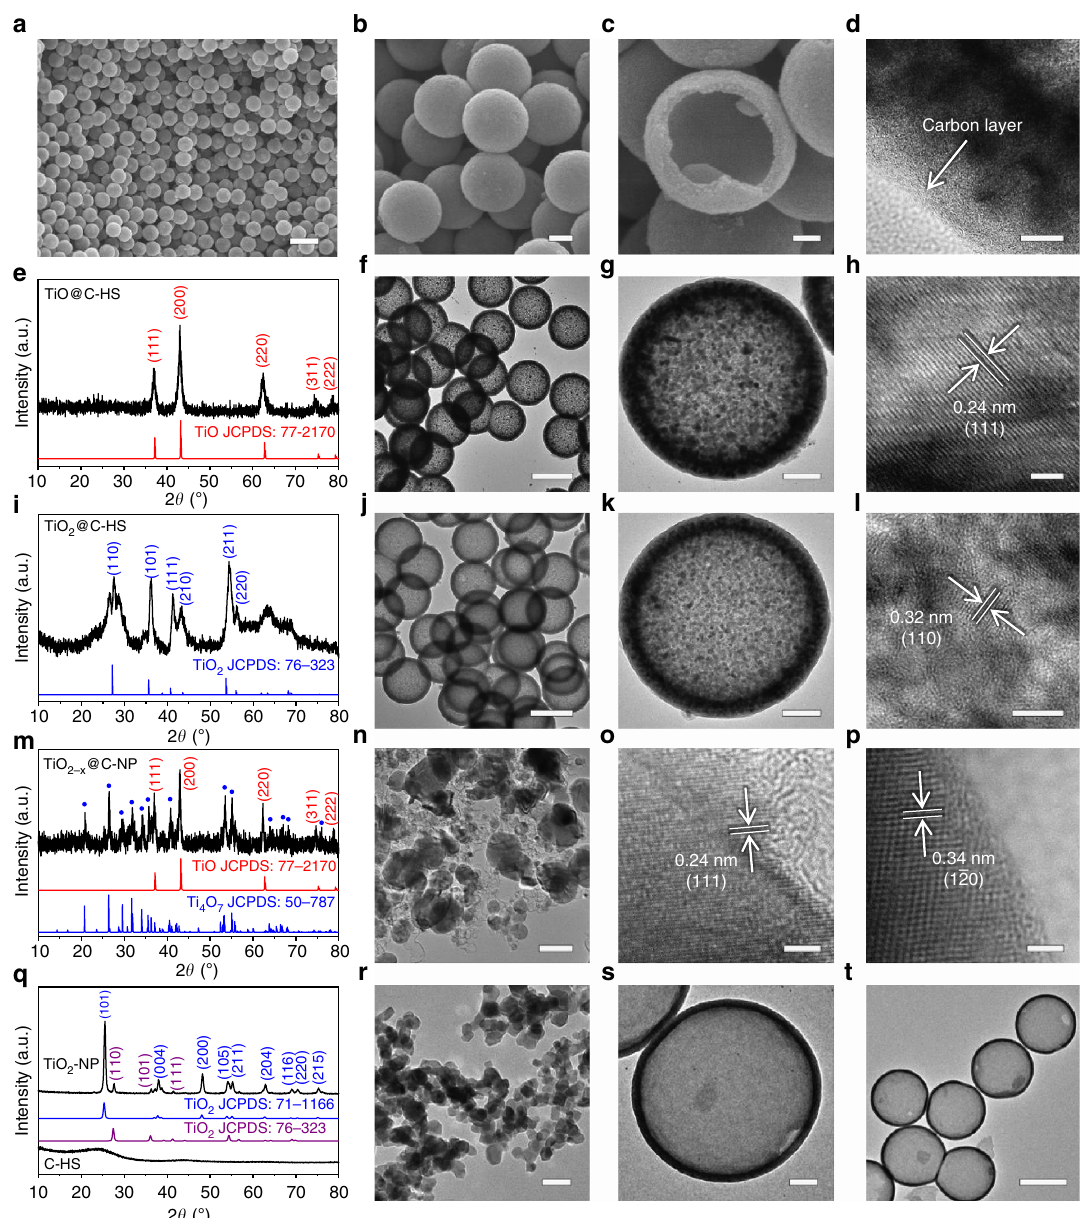
Figure 3 | Characterization of TiO@C-HS and other control host materials. ( a – c ) SEM images, ( e , i , m , q ) X-ray diffraction patterns, ( d , f – h , j – l , n – p , r – t ) TEM images of ( a – h ) TiO@C-HS, ( i – l ) TiO 2 @C-HS, ( m – p ) TiO 2 (cid:2) x @C-NP, ( q , r ) TiO 2 -NP and ( s , t ) C-HS. Scale bars, 1 m m ( a ), scale bars, 200nm ( b ), scale bars, 100nm ( c , g , k , n , s ), scale bars, 500nm ( f , j , t ), scale bars, 10nm ( d ), scale bars, 5nm ( l ), scale bars, 2nm ( h , o , p ), scale bars, 50nm ( r ). a.u., arbitrary